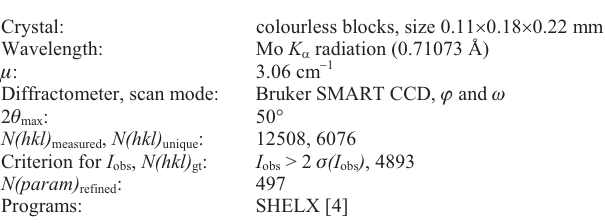
Table 1. Data collection and handling.